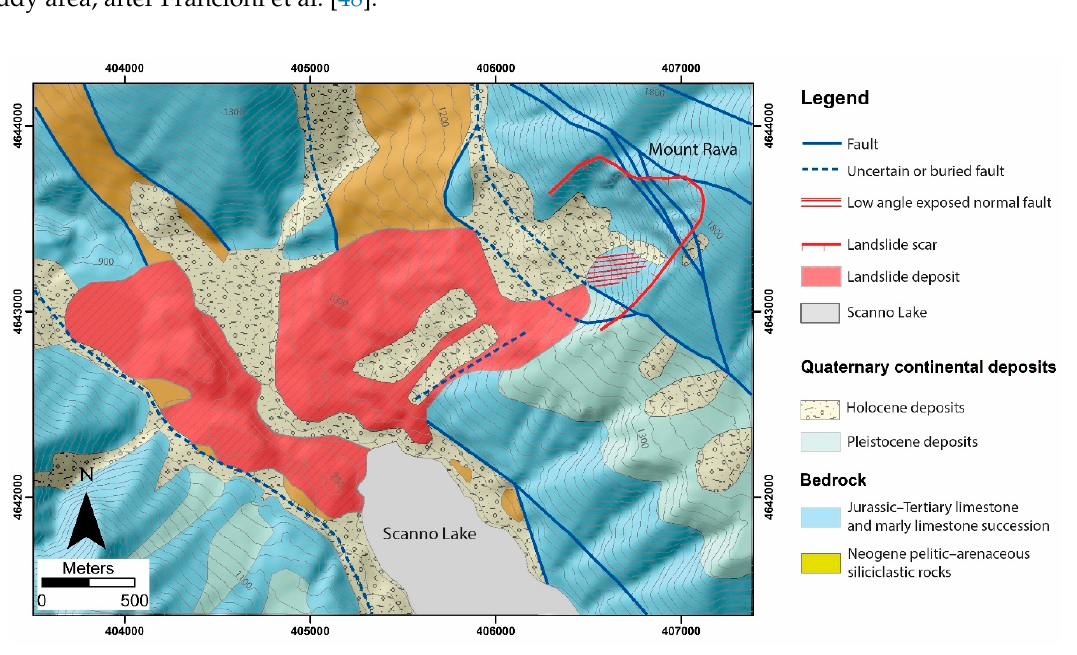
Figure 2. Simplified geological map of the study area (Coordinate system: WGS 84, UTM zone 33 – Projection: Transverse Mercator).